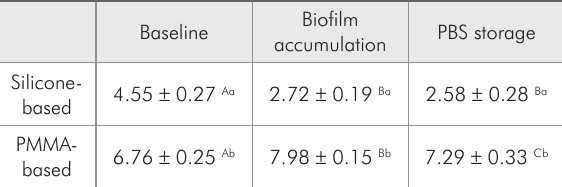
Different uppercase letters indicate statistical differences between baseline, biofilm accumulation, and PBS storage groups. Different lowercase letters indicate statistical differences between liner types.